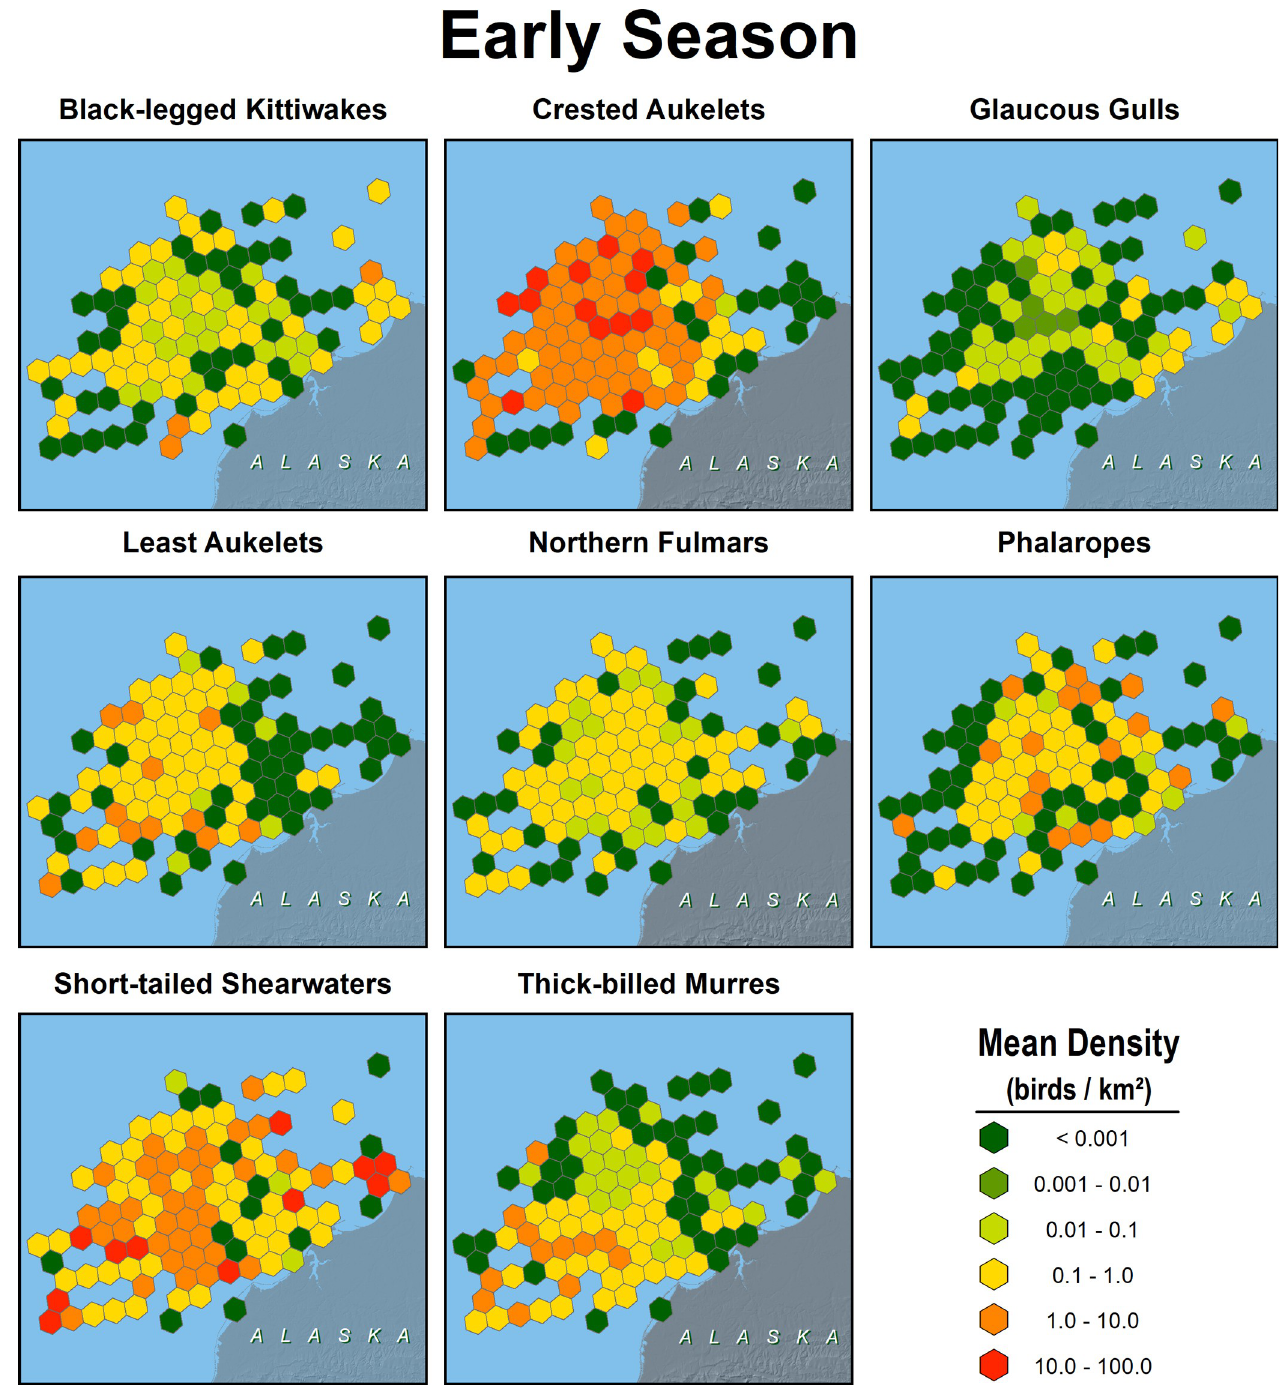
Fig 8. Distribution of 8 species of seabirds in the northeastern Chukchi Sea, early summer 2008–2018. Values in cells are means of transects from surveys conducted during 13 August–6 September. season. In general, auklets and murres, species that feed almost exclusively by diving, had dis- tributions that were well-predicted by latitude and distance to shore. Thick-billed murres and least auklets were more abundant south of 71˚N whereas crested auklets were distributed